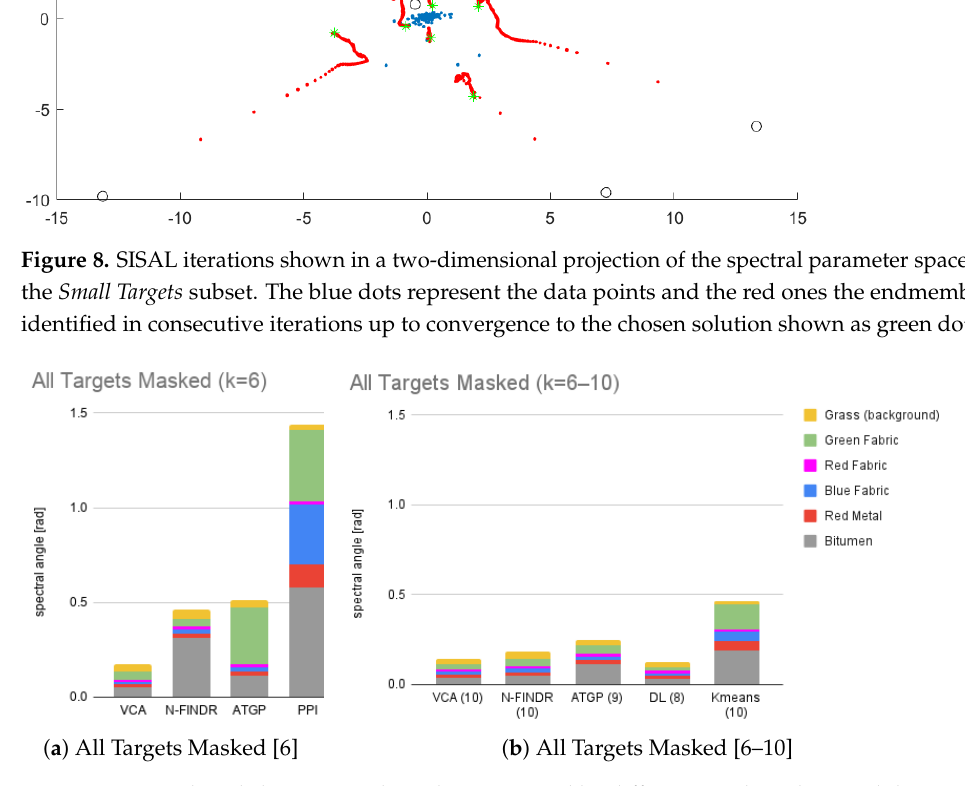
Figure 9. Spectral angle between endmembers extracted by different EE algorithms and the HySpex reference spectra reported in Figure 5. In ( a ), the input number of endmembers k = 6 has been used, while in ( b ) the best k between 6 and 10 was chosen according to the best results ( k indicated in parenthesis for each